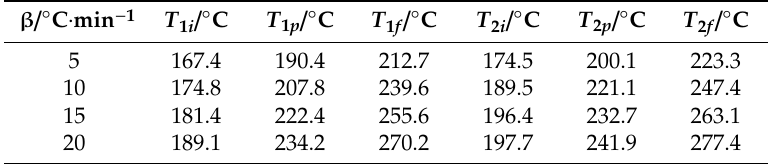
Table 1. Data of the EHTPB-IPDI and HTPB-IPDI systems. Table 2. Kinetic parameters of the curing reactions of the EHTPB-IPDI and HTPB-IPDI systems.